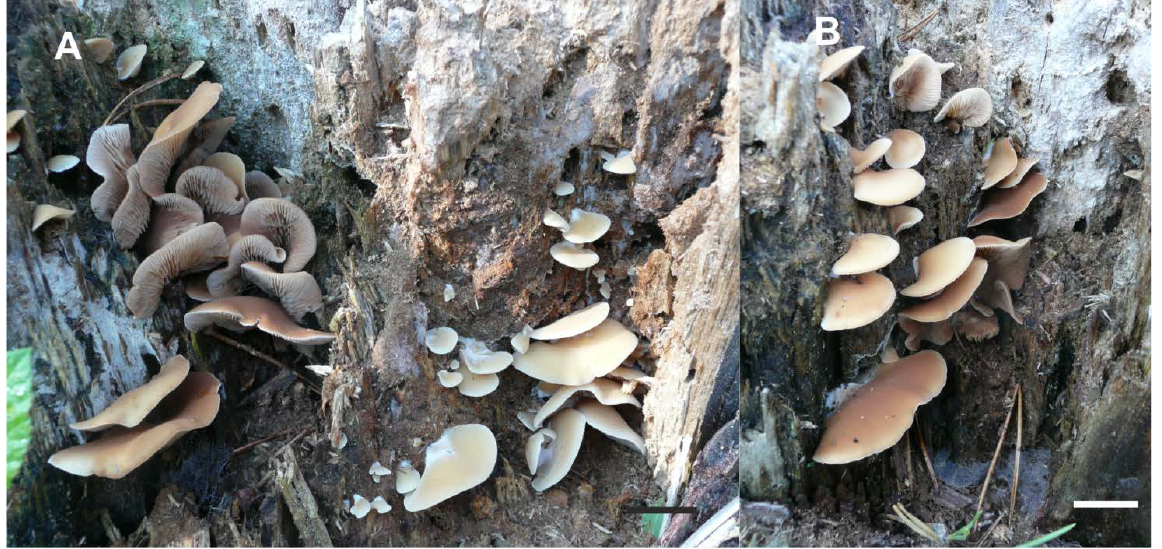
Figure 7. Sessile basidiomata of Crepidotus pini (SLO 2579). ( A ) Young basidiomata with greyish-yellow pileus surface (right) and mature basidiomata with brown lamellae (left), ( B ) mature basidiomata with more brownish pileus surface, (Scale bar = 1 cm ) .